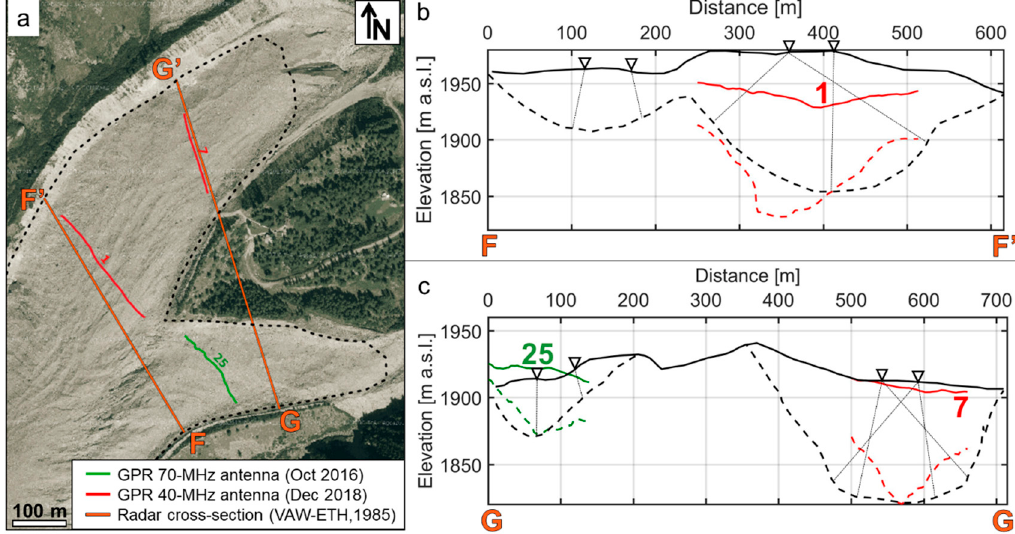
Figure 10. Comparison between the radar cross-sections of VAW-ETH [36] and the closest GPR profiles of the present study with successful glacier bottom picking. ( a ) Location of the profiles. ( b ) Section FF’. ( c ) Section GG’. The original data interpretation is shown in black (white triangles and gray rays indicate the radar measurement points and the interpreted EM ray paths as reported in [36]), while recent GPR results are shown in red for Profiles 1 and 7 (40 MHz, December 2018) and in green for Profile 25 (70 MHz, October 2016). Bold line: Topography, dashed line: Estimated ice bottom location.